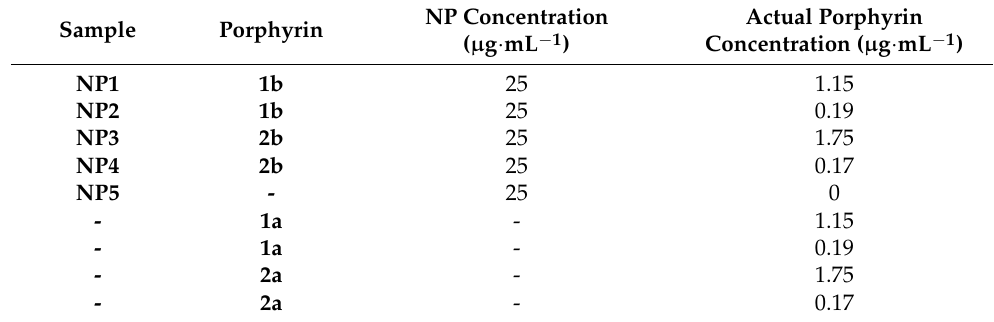
Table 5. Actual concentrations of porphyrin used for TPEF imaging and 2P-PDT experiments.